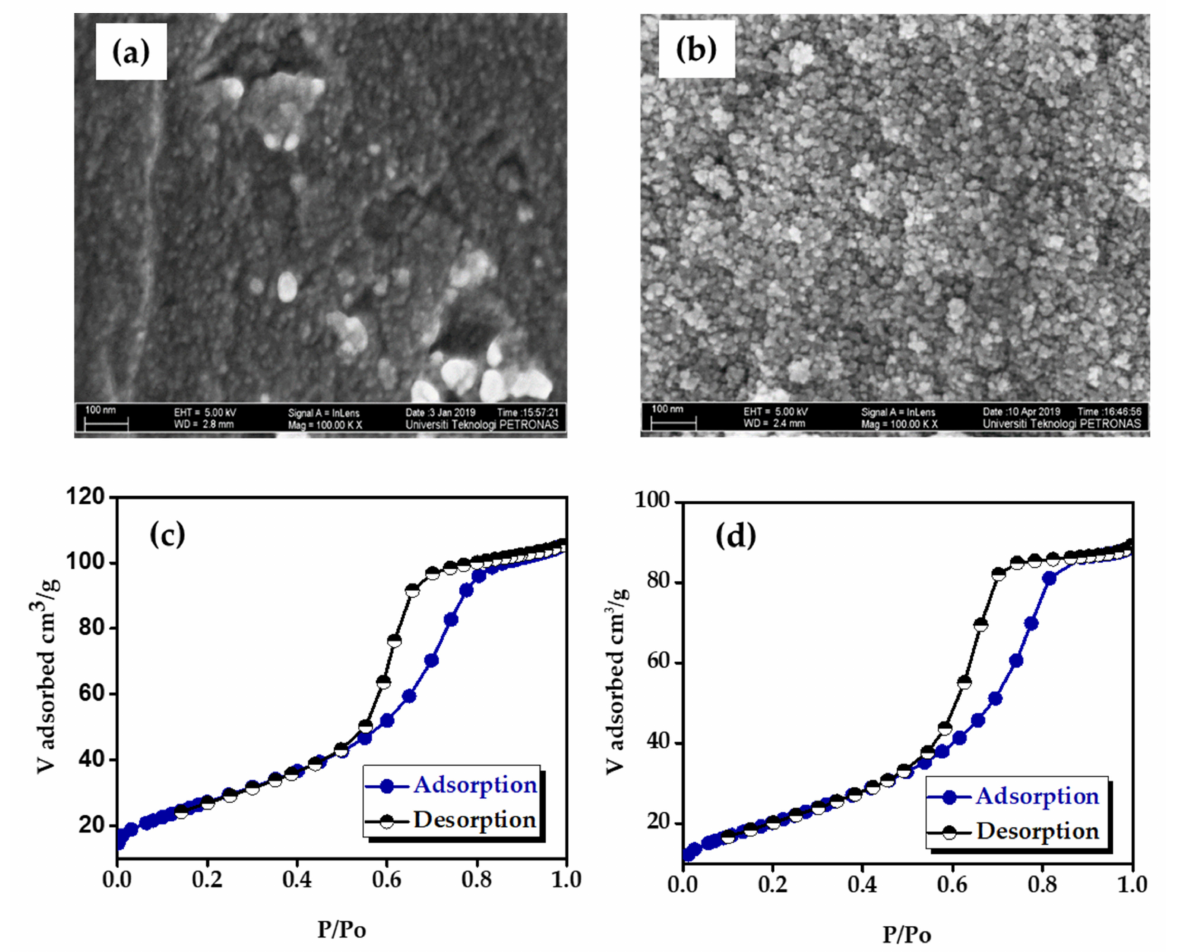
Figure 4. FESEM images of ( a ) B-TiO 2 and ( b ) Mn-B-TiO 2 NPs and N 2 adsorption–desorption isotherms of ( c ) B-TiO 2 and ( d ) Mn-B-TiO 2